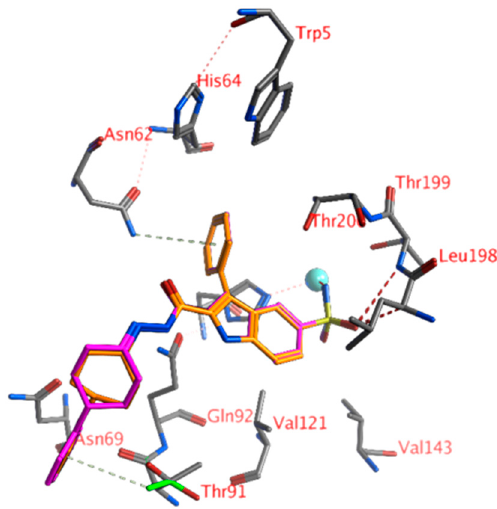
Figure 4. The docked pose of compound 20 (orange) and 21 (purple) in the active site of hCA XII (1jd0). Hydrogen bonds and interactions with the zinc ion are indicated in red dashed lines. H-arene interactions are indicated in yellow dashed lines. The zinc ion is indicated as a turquoise sphere. The Thr91 rotamer that was able to form an H-arene interaction with 21 is indicated in green sticks.